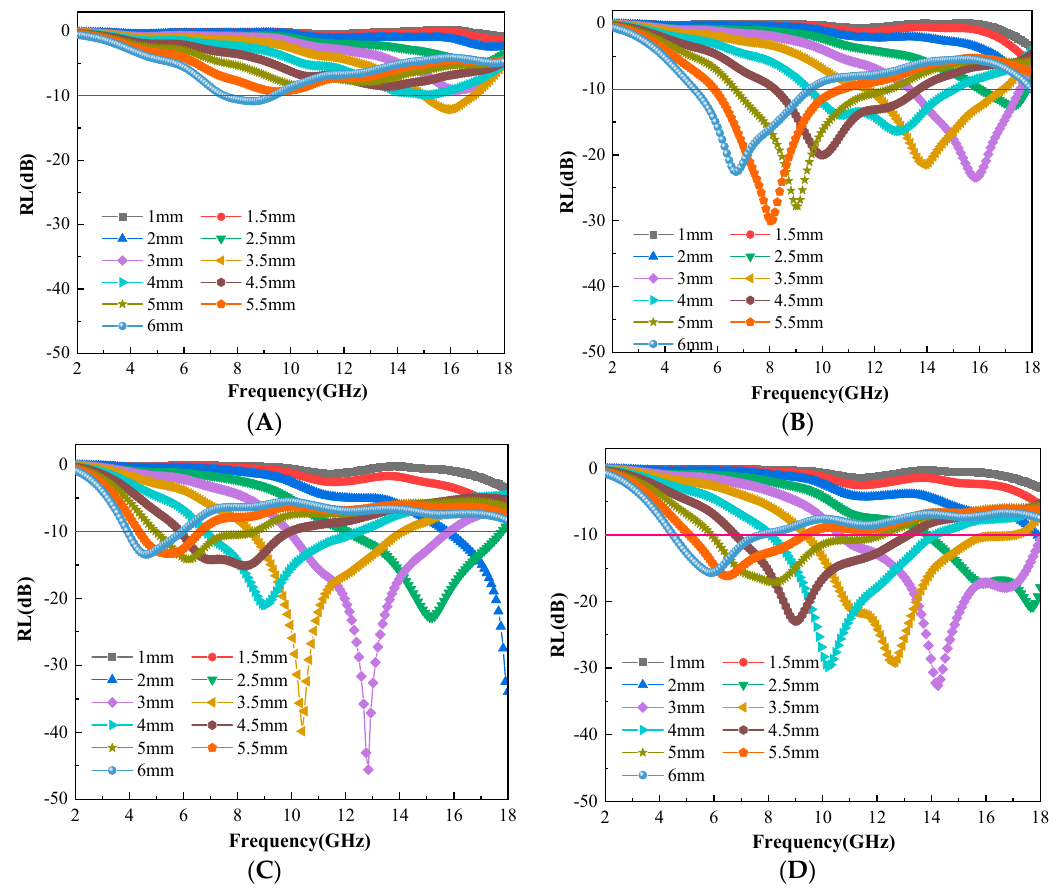
Figure 9. Loss of C/Fe 3 O 4 : MC-1 ( A ); MC-2 ( B ); MC-3 ( C ); MC-4 ( D ). Figure 9. Loss of C / Fe 3 O 4 : MC-1 ( A ); MC-2 ( B ); MC-3 ( C ); MC-4 ( D